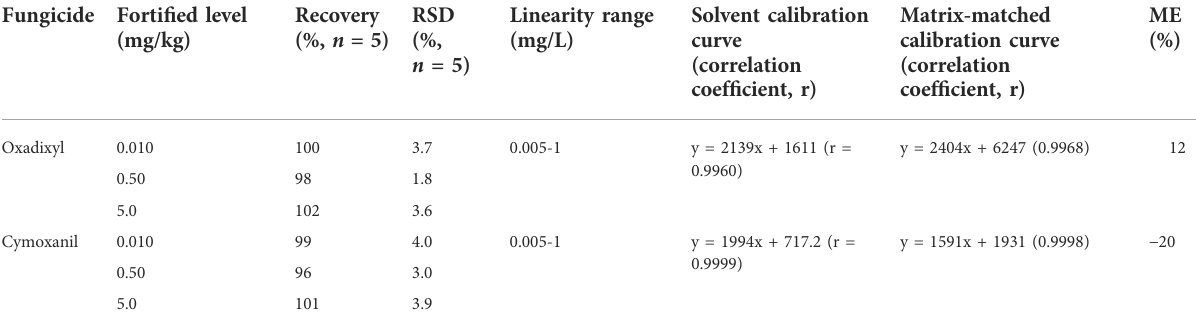
TABLE 4 Method validation results for oxadixyl and cymoxanil in